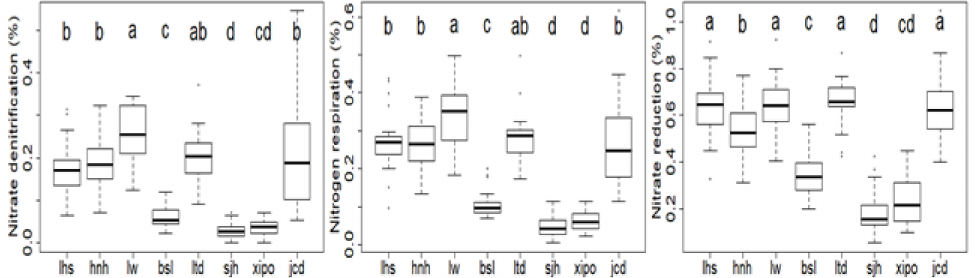
Figure 6. Bacterial function groups along the elevation gradient. Different letters (a–e) indicate significant differences among different sampling